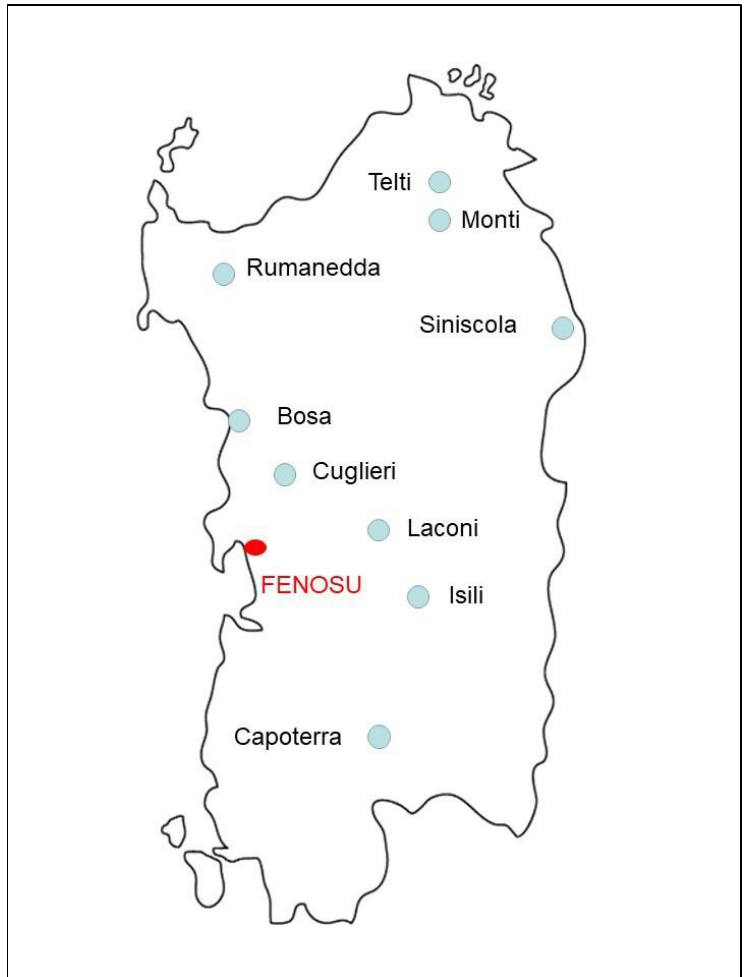
Figure 1. Sites of origin map of the studied cultivars correspond to the pale blue points. The red point corresponds to the repository of Fenosu experimental station.